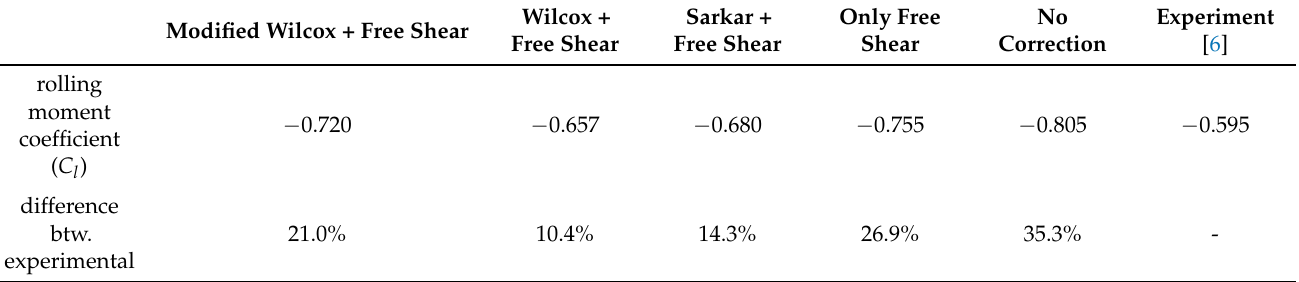
Figure 15. Comparison of TKE field obtained with different compressibility correction settings; = 5 × 10 5 , λ = 45°; Kato-Launder production; Row 1: modified Wilcox with free M = 0.85, Re d Ref shear correction (described by Abdol-Hamid et al. [12]), Row 2: Wilcox with free shear correction, Row 3: Sarkar with free shear correction, Row 4: only free shear correction, Row 5: no correction Table 6. Computed rolling moment results with different compressibility correction